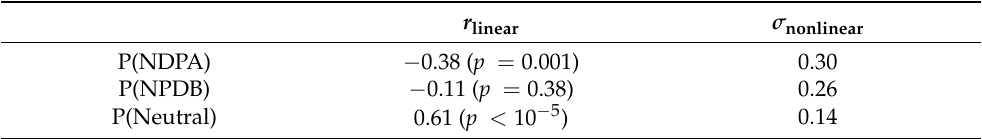
Figure 7. Probabilities of variants to be neutral ( a ), NPDA-associated ( b ) and NPDB-associated ( c ) predicted by SMPD1-ZooM as a function of the relative activity R of SMPD1 variants (in %), for the 69 variants for which this activity has been measured. The colors of the points refer to the available clinical annotations. The continuum lines are fitting curves defined in Equation (6). Table 5. Linear correlation coefficient ( r linear ) between the measured relative activity of SMPD1 variants and the probability of variants to be in one of the three classes predicted by SMPD1-ZooM, with the p -value in parentheses; root mean square deviation ( σ nonlinear ) between the probability values and the fitted curves depicted in Figure